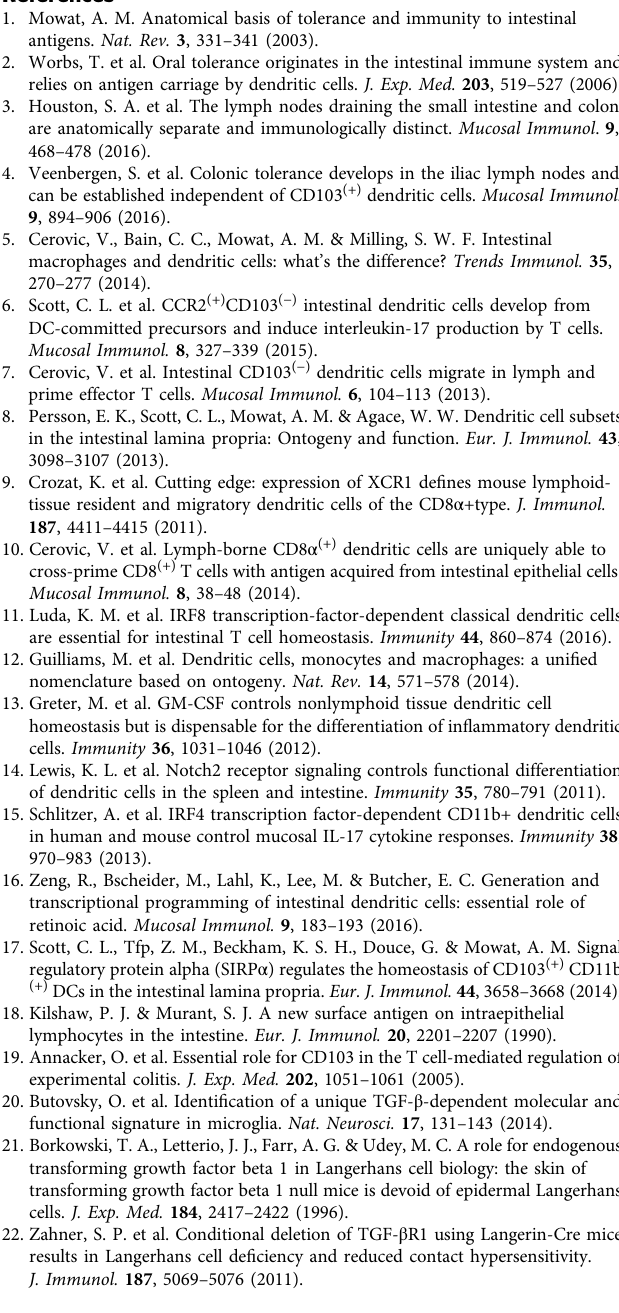
Data availability . Microarray data that support the fi ndings of this study have been deposited in National Center for Biotechnology Information Gene